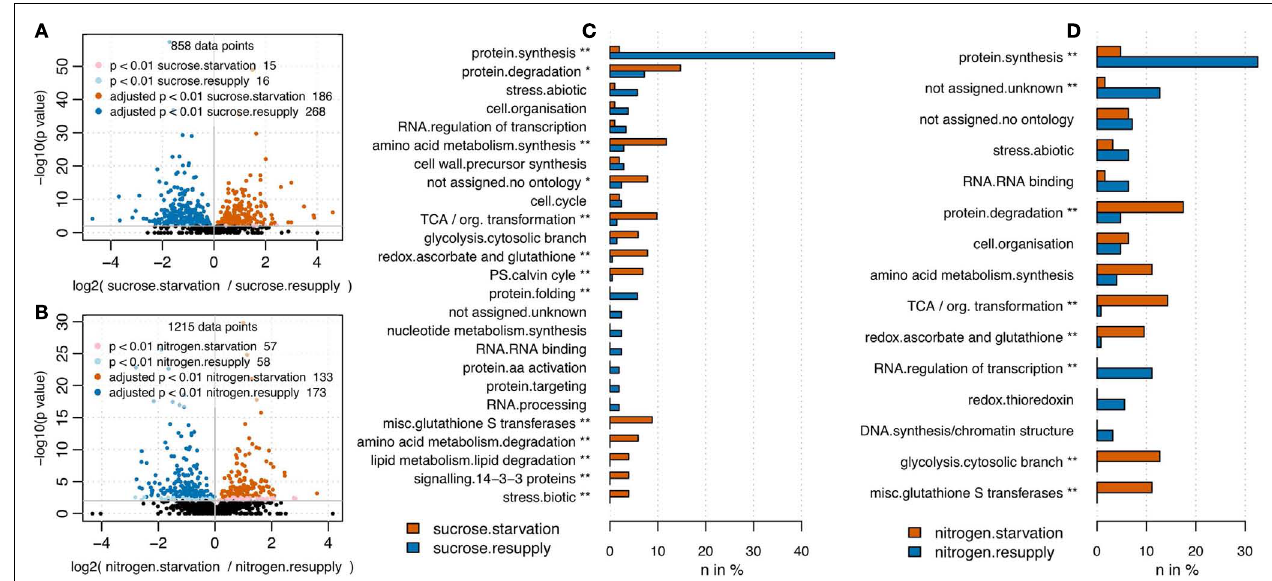
by more than two proteins are shown. For sucrose (C) as well as nitrogen starvation (D) the bin “protein.synthesis” was significantly depleted under starvation, whereas the bins “glycolysis.cytosolic branch,” “misc.glutathione S transferases,” “redox.ascorbate and glutathione,” “TCA/org. transformation” were significantly up-regulated under full nutrition. In general starvation under sucrose affected slightly more categories (11 significantly overrepresented bins) compared to nitrogen starvation (8 significantly overrepresented bins). *Uncorrected p value < 0.05; **Benjamini Hochberg corrected p value <